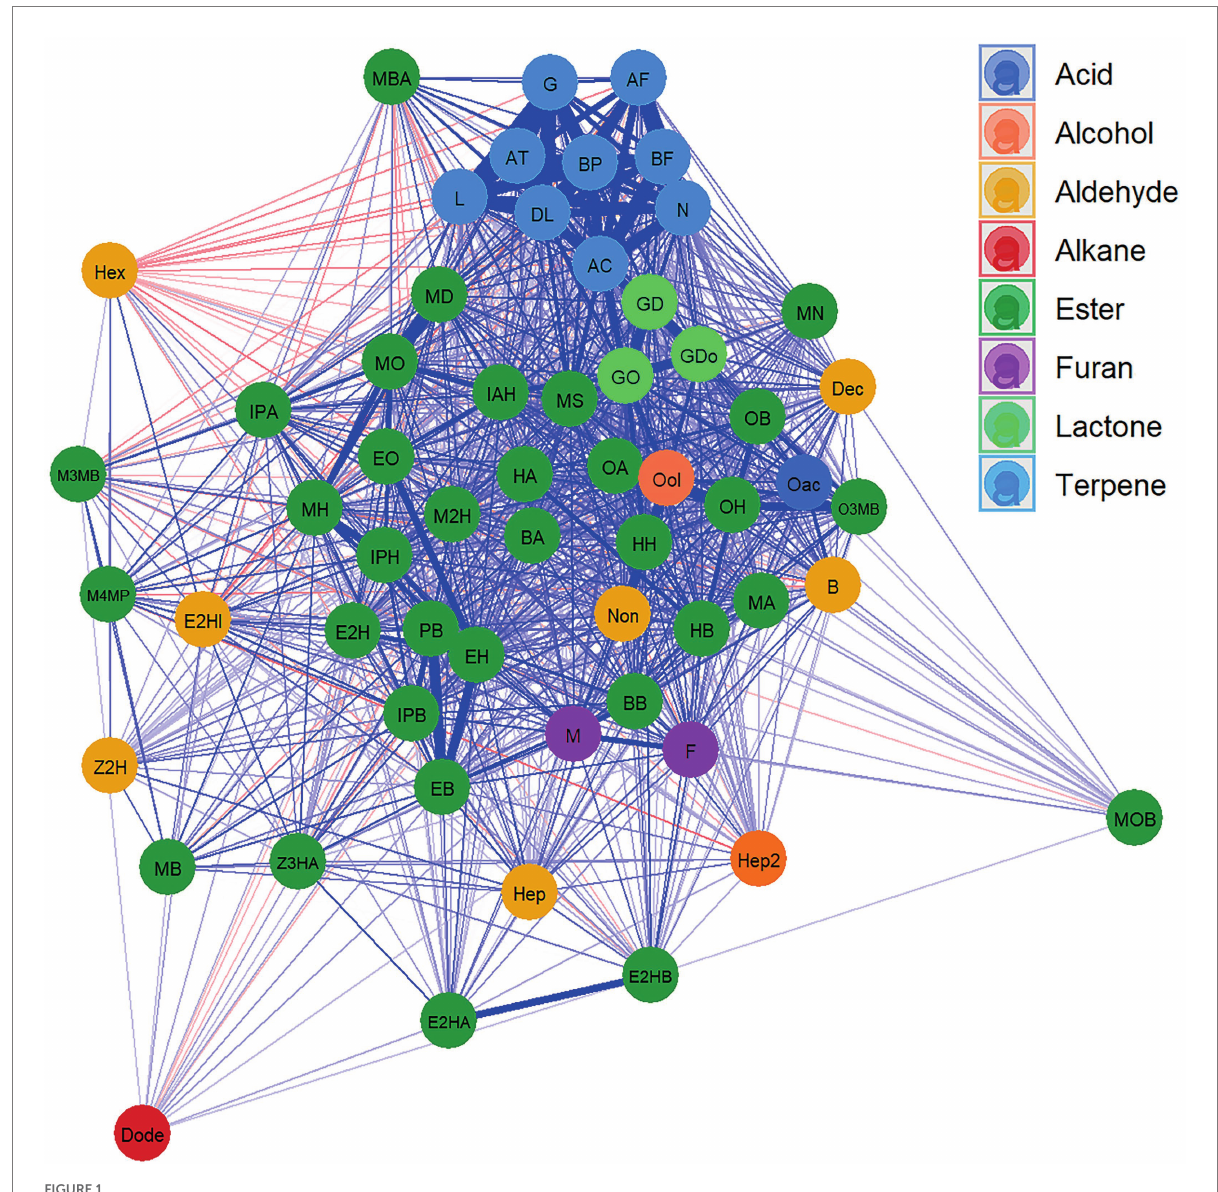
FIGURE 1 Cluster network analysis (CNA) for VOCs in “FC50 × FD54.” Compounds are represented as nodes and colored according to the chemical families. Positive (blue) and negative (red) correlation are represented as link between compounds, the widest links being the strongest correlation. Showing correlations with p value <0.05. For the correspondences between the full name and their abbreviation names consult Table